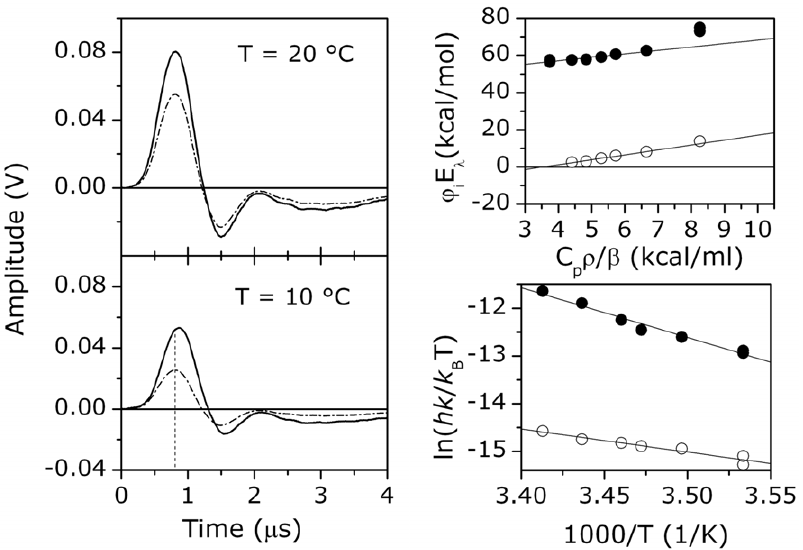
Figure 5. Laser-induced optoacoustic spectroscopy data. Left : LIOAS signals of a 10 2 5 M Tf -trHb solution in phosphate buffer at 0.1 M ionic strength (continuous line) and of a calorimetric reference solution at 20 u C ( upper panel ) and at 10 u C ( lower panel ). A vertical line marks the first maximum of the reference signal at 10 u C to highlight the time shift of the sample signal. Right : ( upper panel ) Plot of the decay amplitudes w i - multiplied by the laser energy E l - for the prompt ( full circles ) and the slow ( hollow circles ) components of the LIOAS signals vs the thermoelastic parameter ratio C p r / b . Linear least-square fittings are superimposed on the data. (lower panel) Eyring plots for the prompt ( full circles ) and the slow ( hollow circles ) components. Activation enthalpies D H { and entropies D S { are estimated for each rate constant k i in the investigated temperature range, according to the equation: ln( hk i / k B T ) ) = D S { /R – D H { /RT , where R is the gas constant, h is the Planck constant, and k B is the Boltzmann constant.